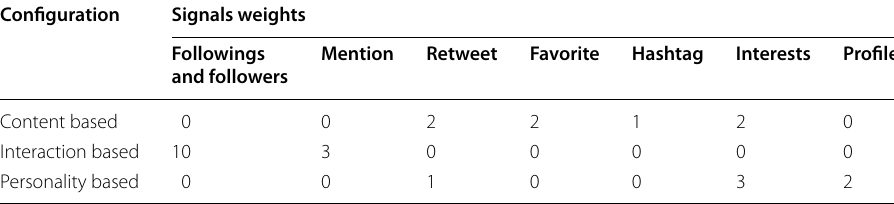
Table 3 Different configurations with different weights